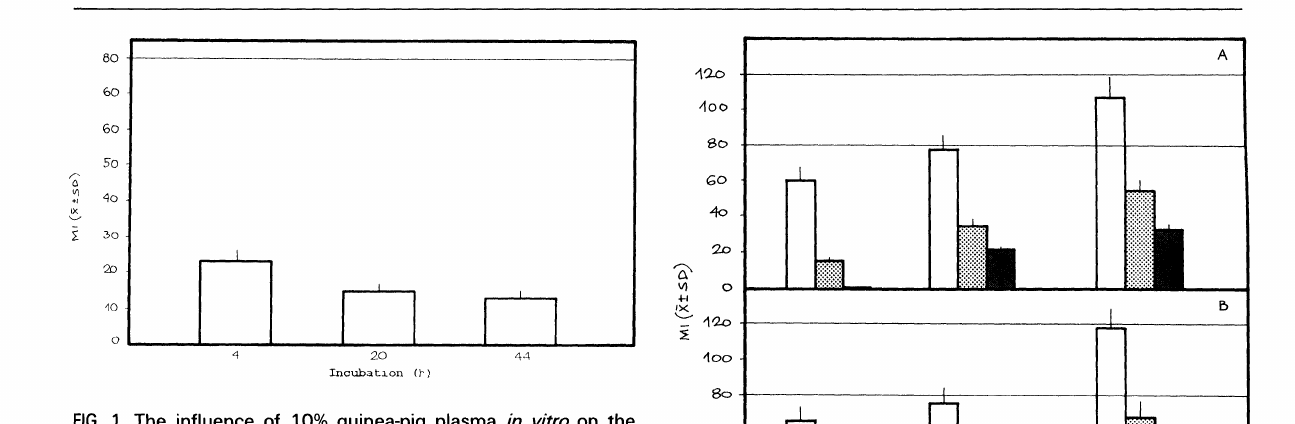
FIG. 1. The influence of 10% guinea-pig plasma in vitro on the random migration of oil-elicited guinea-pig peritoneal 6-day mac- rophages. Migration areas obtained with 10% serum are taken as controls. All experiments were performed two to three times to ensure that the results were consistent and the representative experiment is shown (n 5-7 per group). Significant inhibition, p < 0.001.